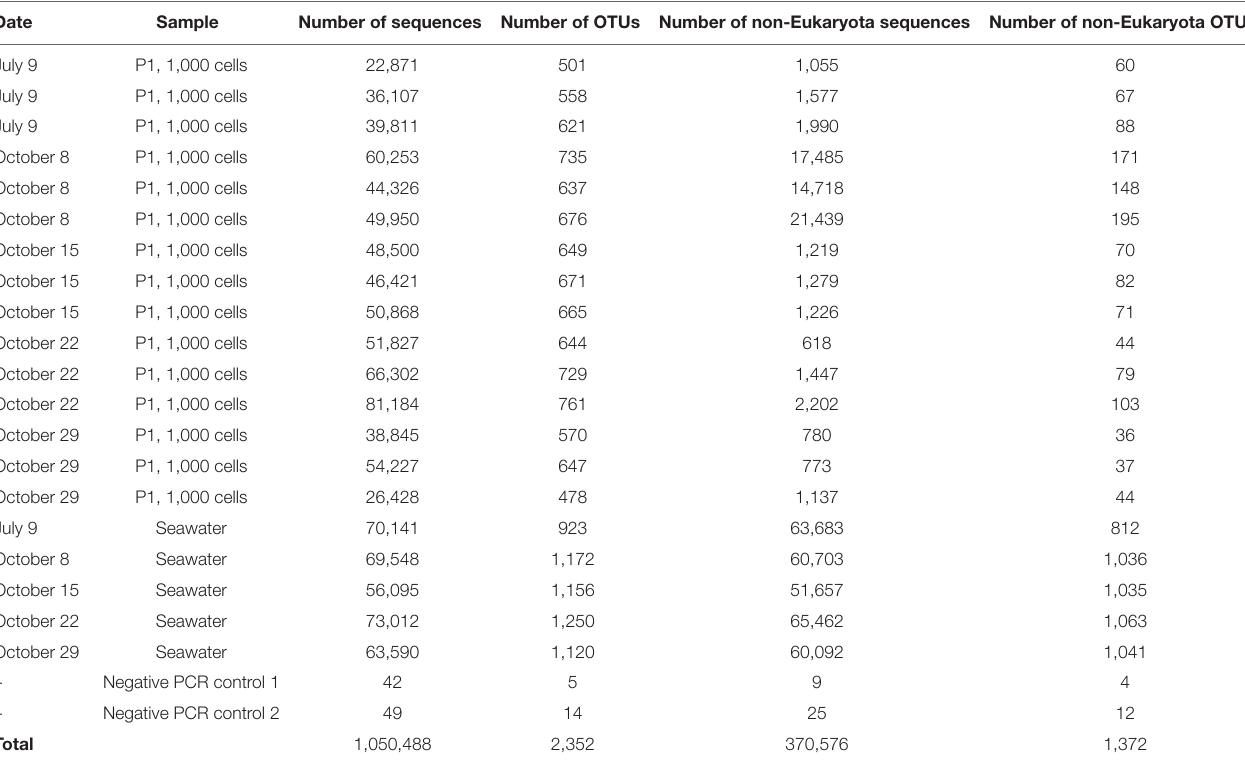
samples ( Figure 3B ). The separation of Synechococcus from the photosynthetic picoeukaryote population was done based on orange fluorescence. Depending on the definition of the sorting gates, some Synechococcus may have been co-sorted if the gate for the orange fluorescence was defined too